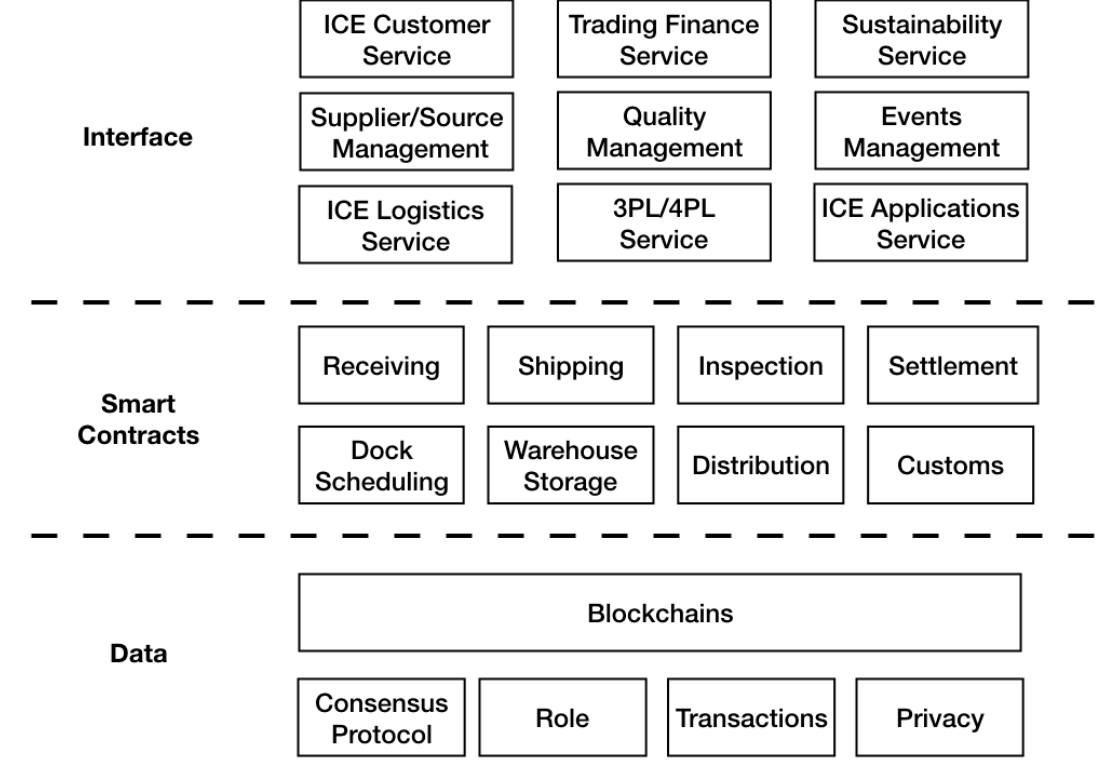
Figure 4. TransICE software structure.